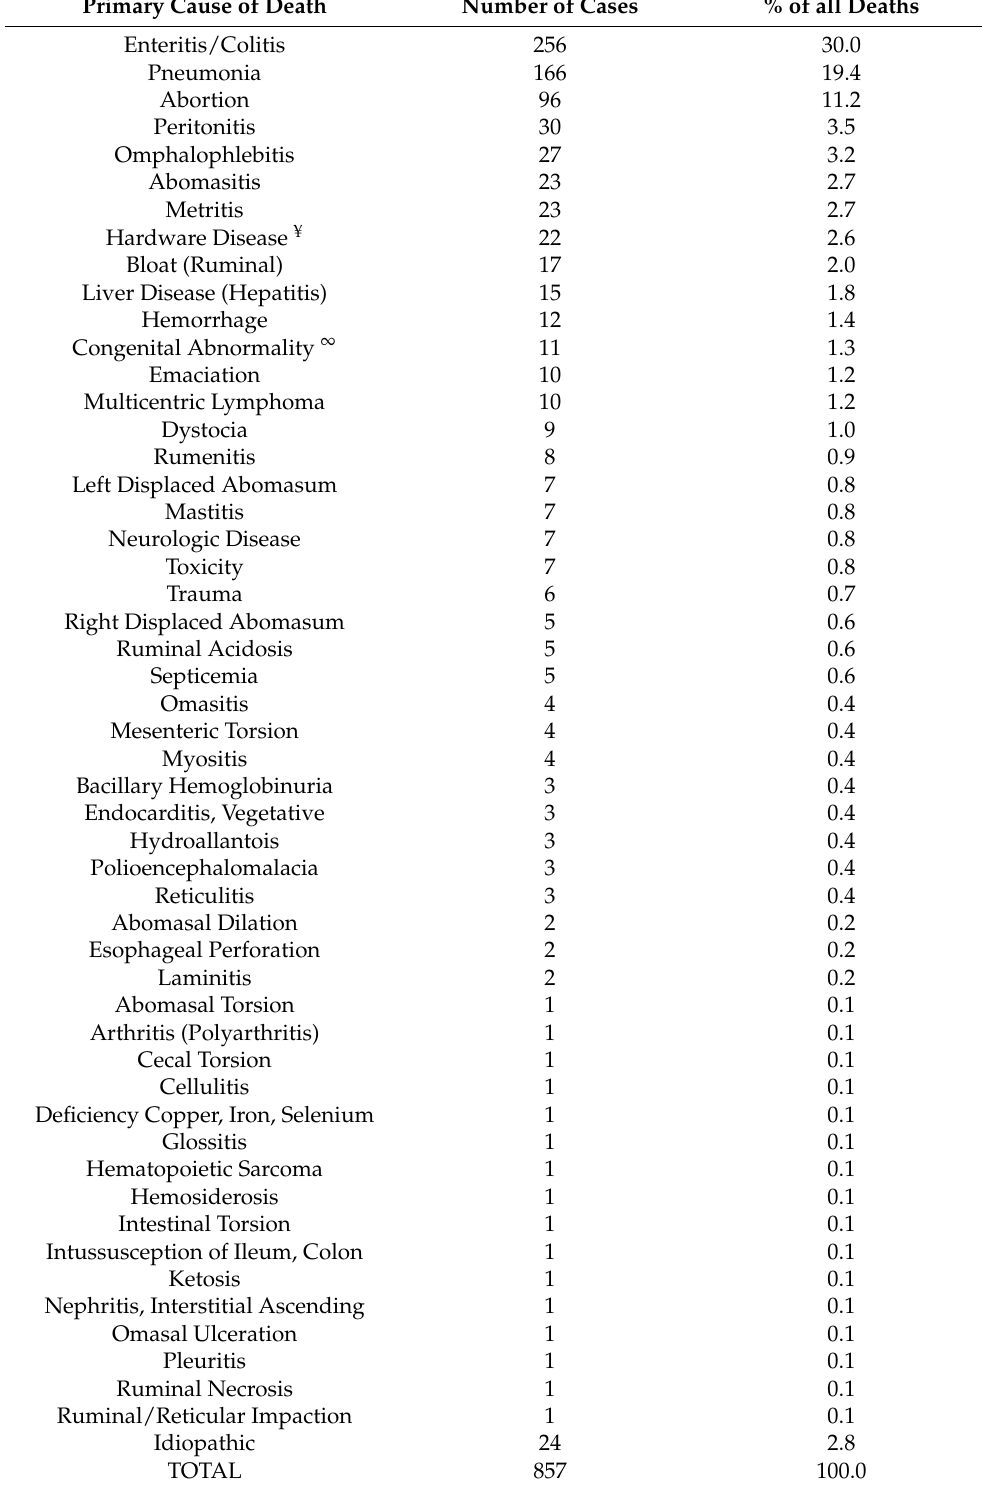
Table 1. Primary cause of death of 857 dairy cattle of all ages, including fetuses, in the Intermountain West diagnosed at necropsy from